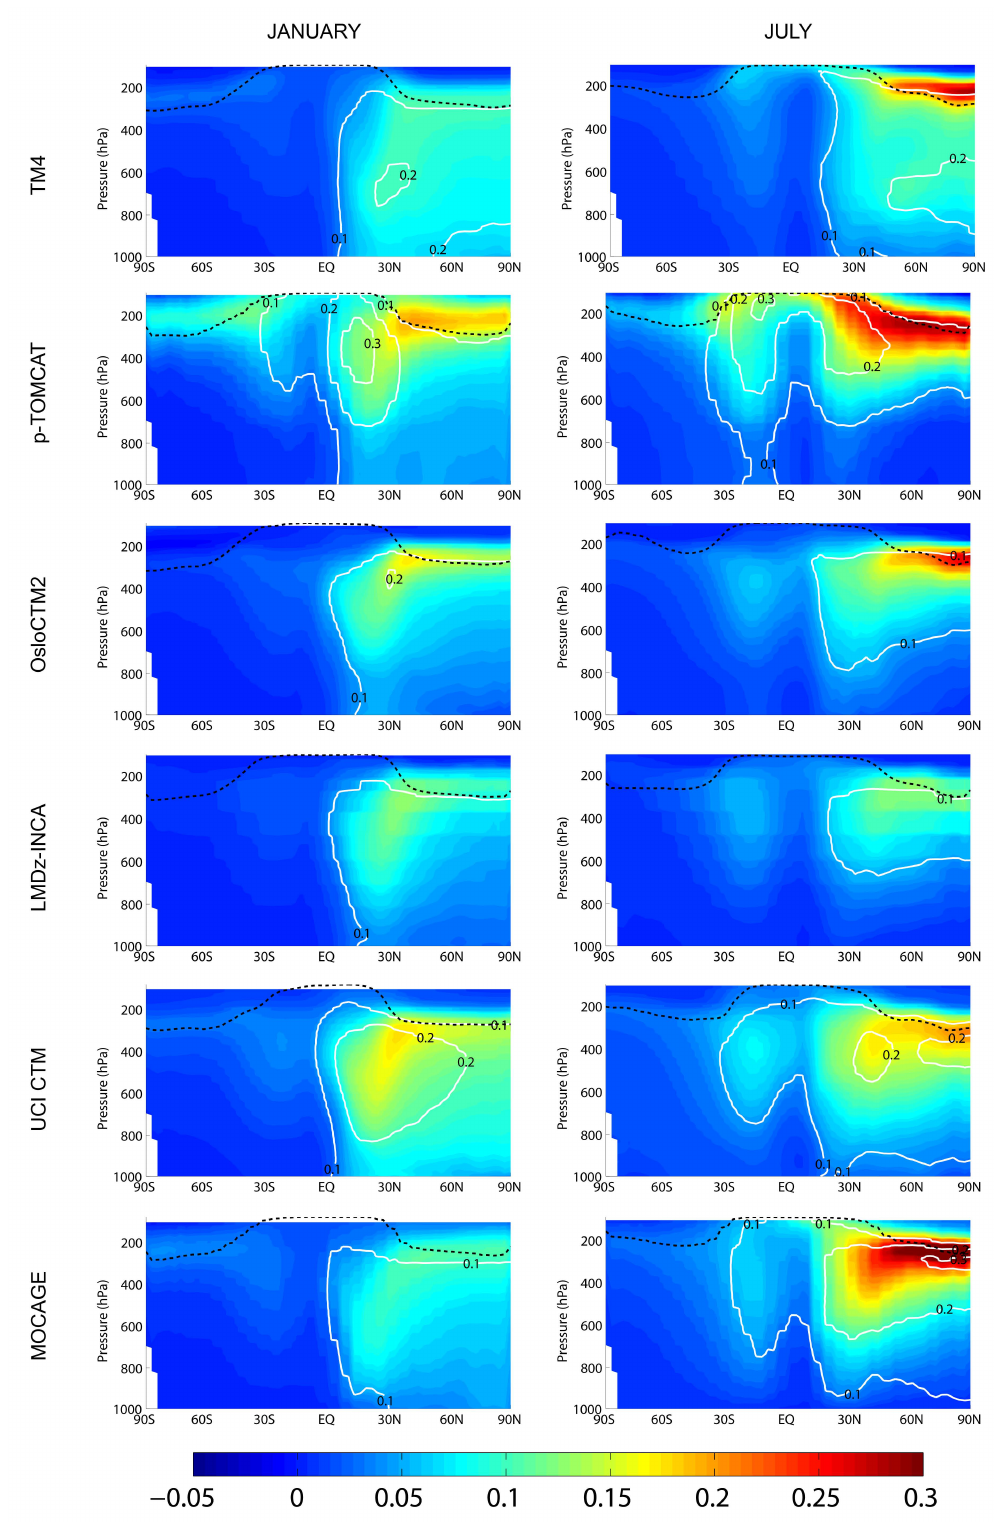
Fig. B1. Zonal mean perturbations of ozone ( 1 ppbv) during January (left) and July (right) for the 2050 B1 scenario, due to a 5% perturbation of aircraft emissions (simulations BASE – AIR). Solid contour lines show the change relative to the BASE simulation while the dashed line indicates the